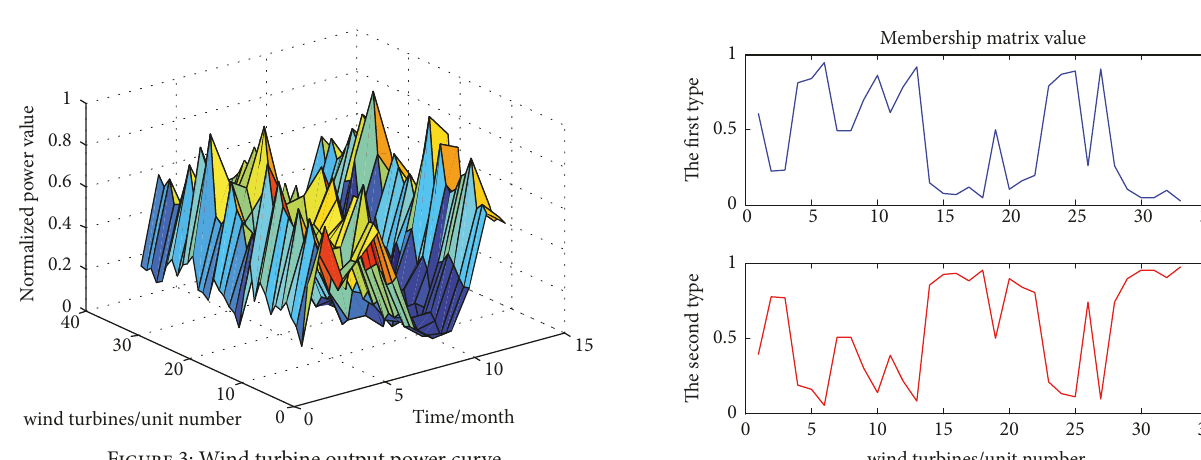
Figure 3: Wind turbine output power curve.